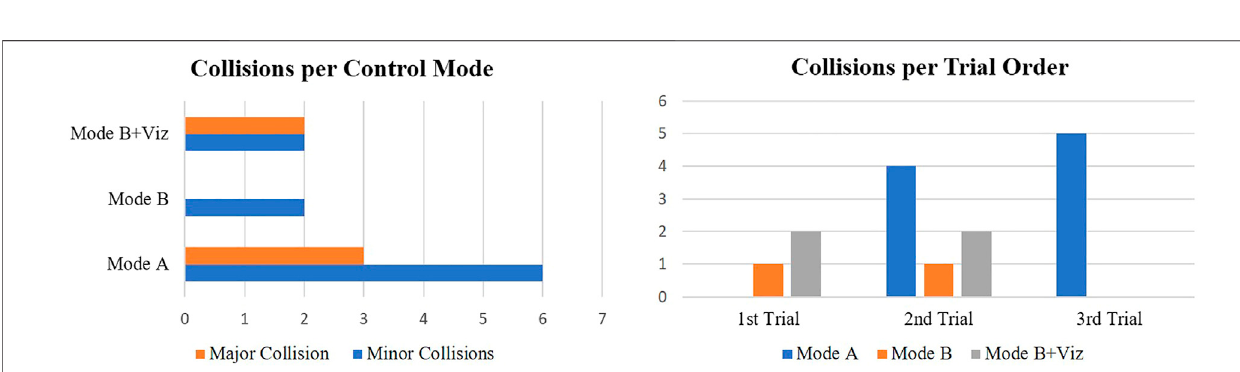
Frontiers in Robotics and AI |